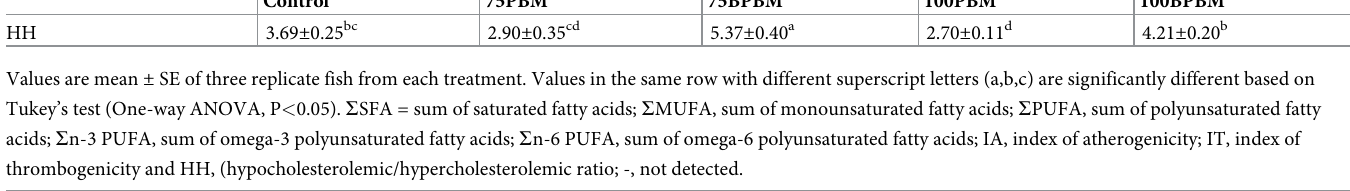
PLOS ONE | https://doi.org/10.1371/journal.pone.0215025 April 9,